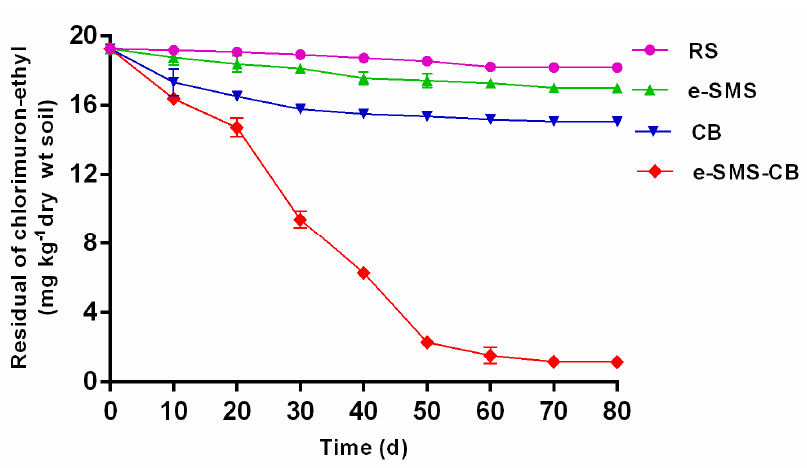
Figure 2. Levels of chlorimuron-ethyl in treated soils. The bars represent the SDs of assays performed in triplicate. RS: real soil as control group; e-SMS: real soil + P. eryngiu- SMS; CB: real soil + co-culture bacteria; e-SMS-CB: real soil + P. eryngiu- SMS-CB.